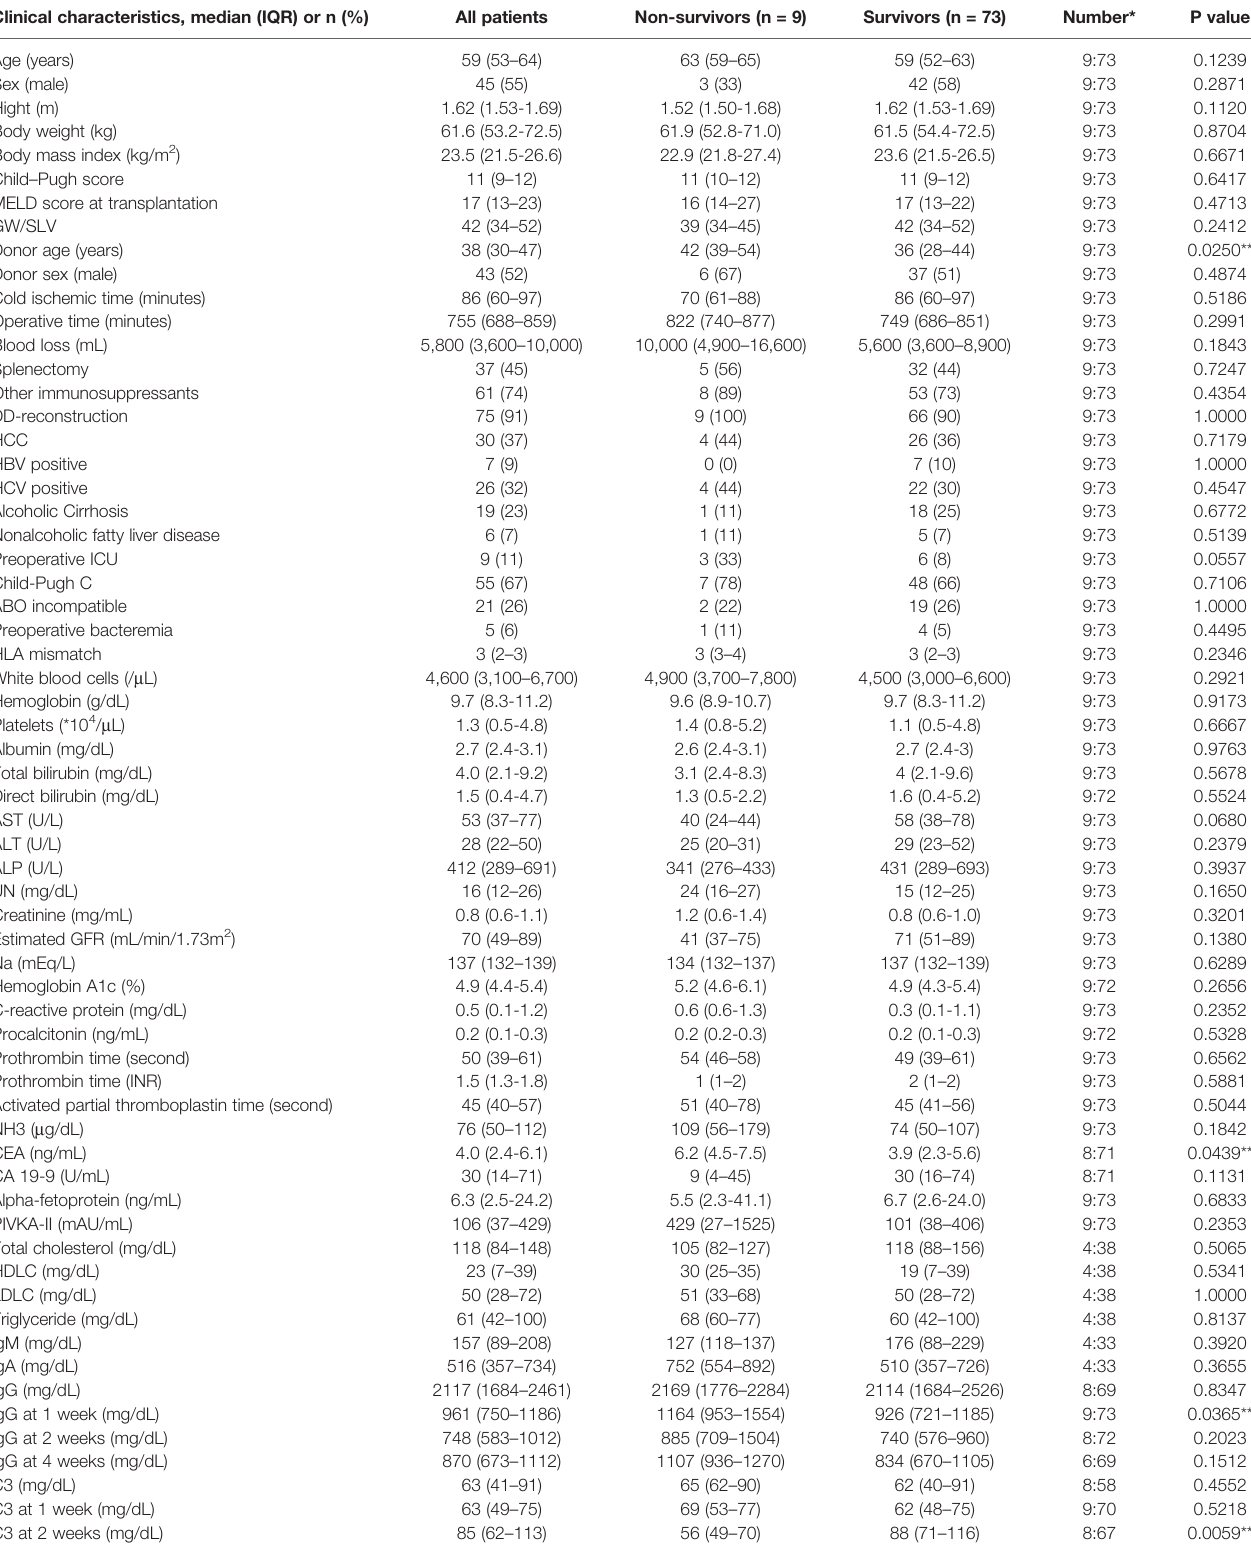
TABLE 1 | Clinical characteristics of all patients, survivors, and non-survivors. Clinical characteristics, median (IQR) or n